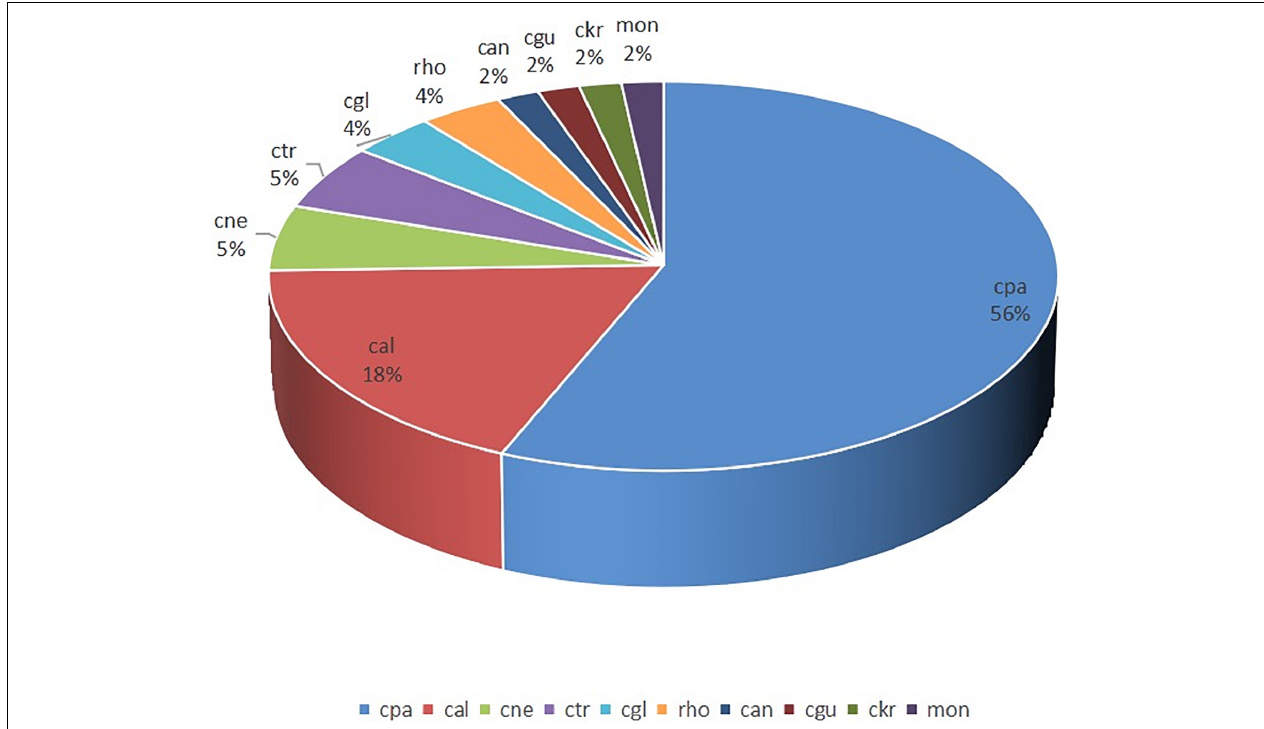
FIGURE 6 | Distribution of fungal strains (%). cpa, C. parapsilosis; cal, C. albicans; cne, Cryptococcus neoformans; ctr, C. tropicalis; cgl, C. glabrata; rho, Rhodotorula; can, Candida spp; cgu, Candida guilliermondii; ckr, C. krusei; and mon,